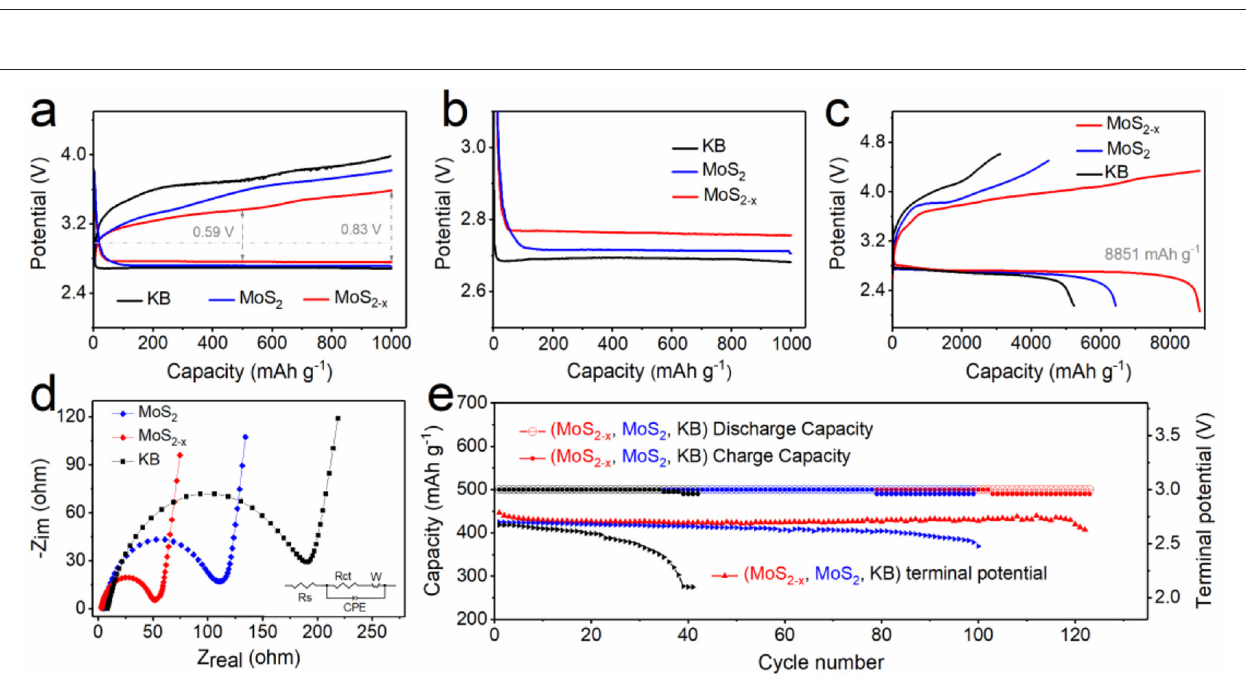
FIGURE 3 | Electrochemical properties. (a) First cycling galvanostatic discharge and recharge profiles of MoS 2 − x , MoS 2 , and Kejen Black. (b) Enlarged image of the discharge curves in (a) . (c) Full discharge and recharge curves of Li–O 2 batteries with MoS 2 − x and MoS 2 cathodes. (d) EIS spectra of MoS 2 − x , MoS 2 , and Kejen Black at open-circuit voltages. The inset is the equivalent circuit. (e) Cycling stability and the terminal discharge potential of MoS 2 − x and MoS 2 cathodes.